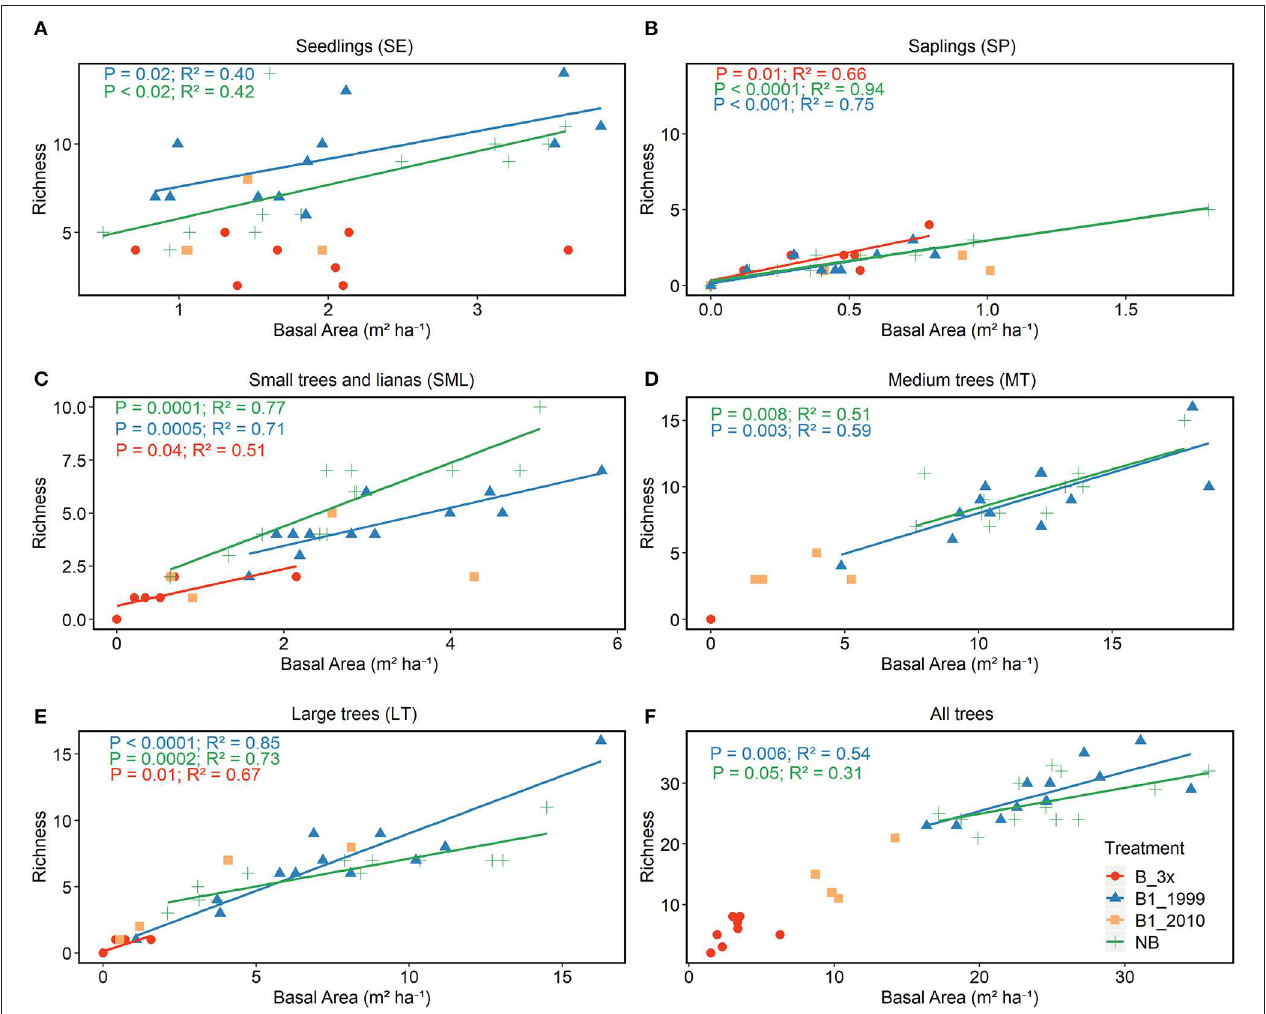
FIGURE 7 | Relationship between richness and basal area. Analyses were conducted separately for each vegetation strata (A) SE, (B) SP, (C) SML, (D) MT, (E) LT, and (F) for all strata